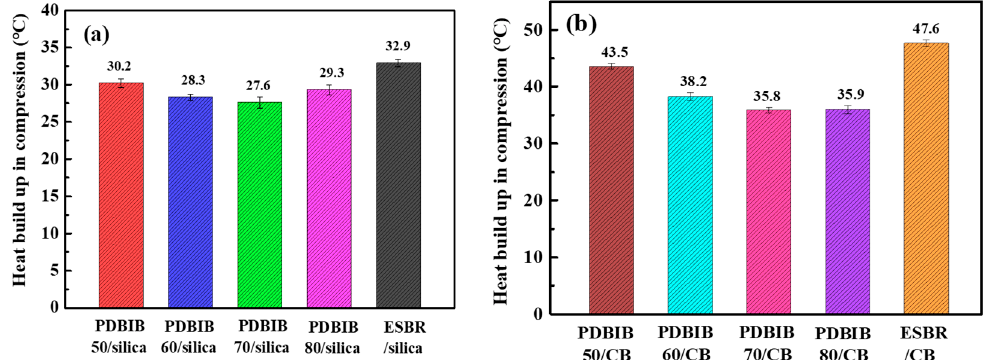
Figure 12. Heat build-up ( a , b ) of PDBIB and ESBR nanocomposites.